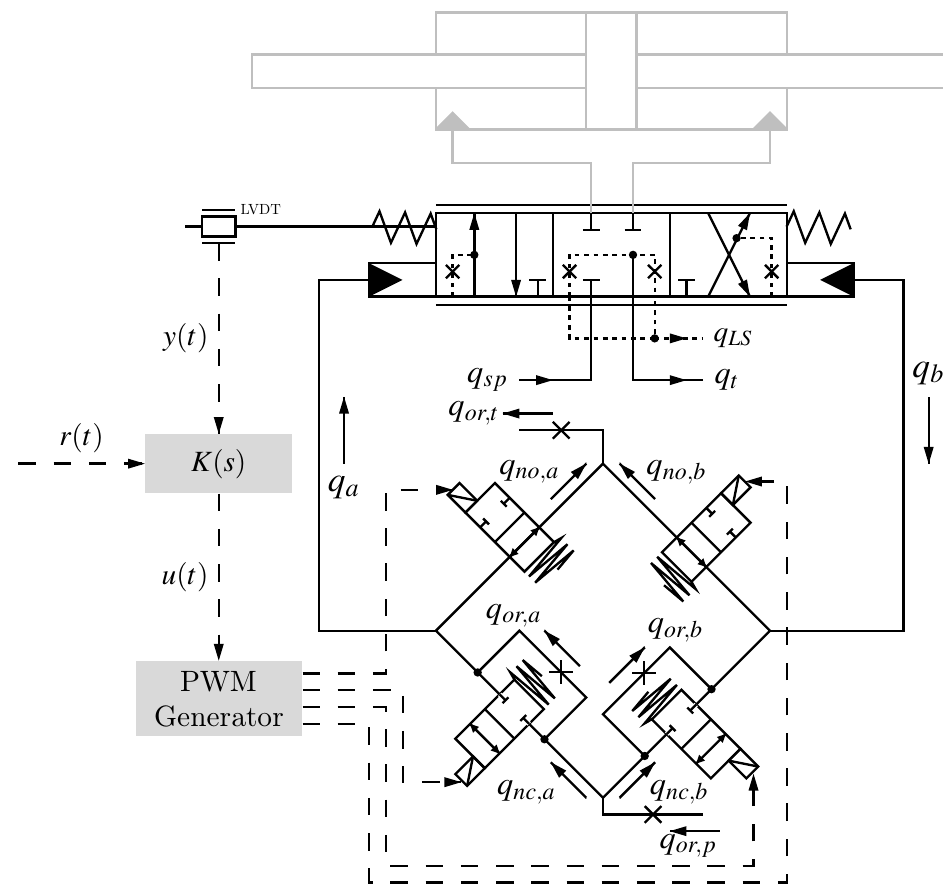
Figure 1. Hydraulic schematic of the directional spool, logic valves, and the working